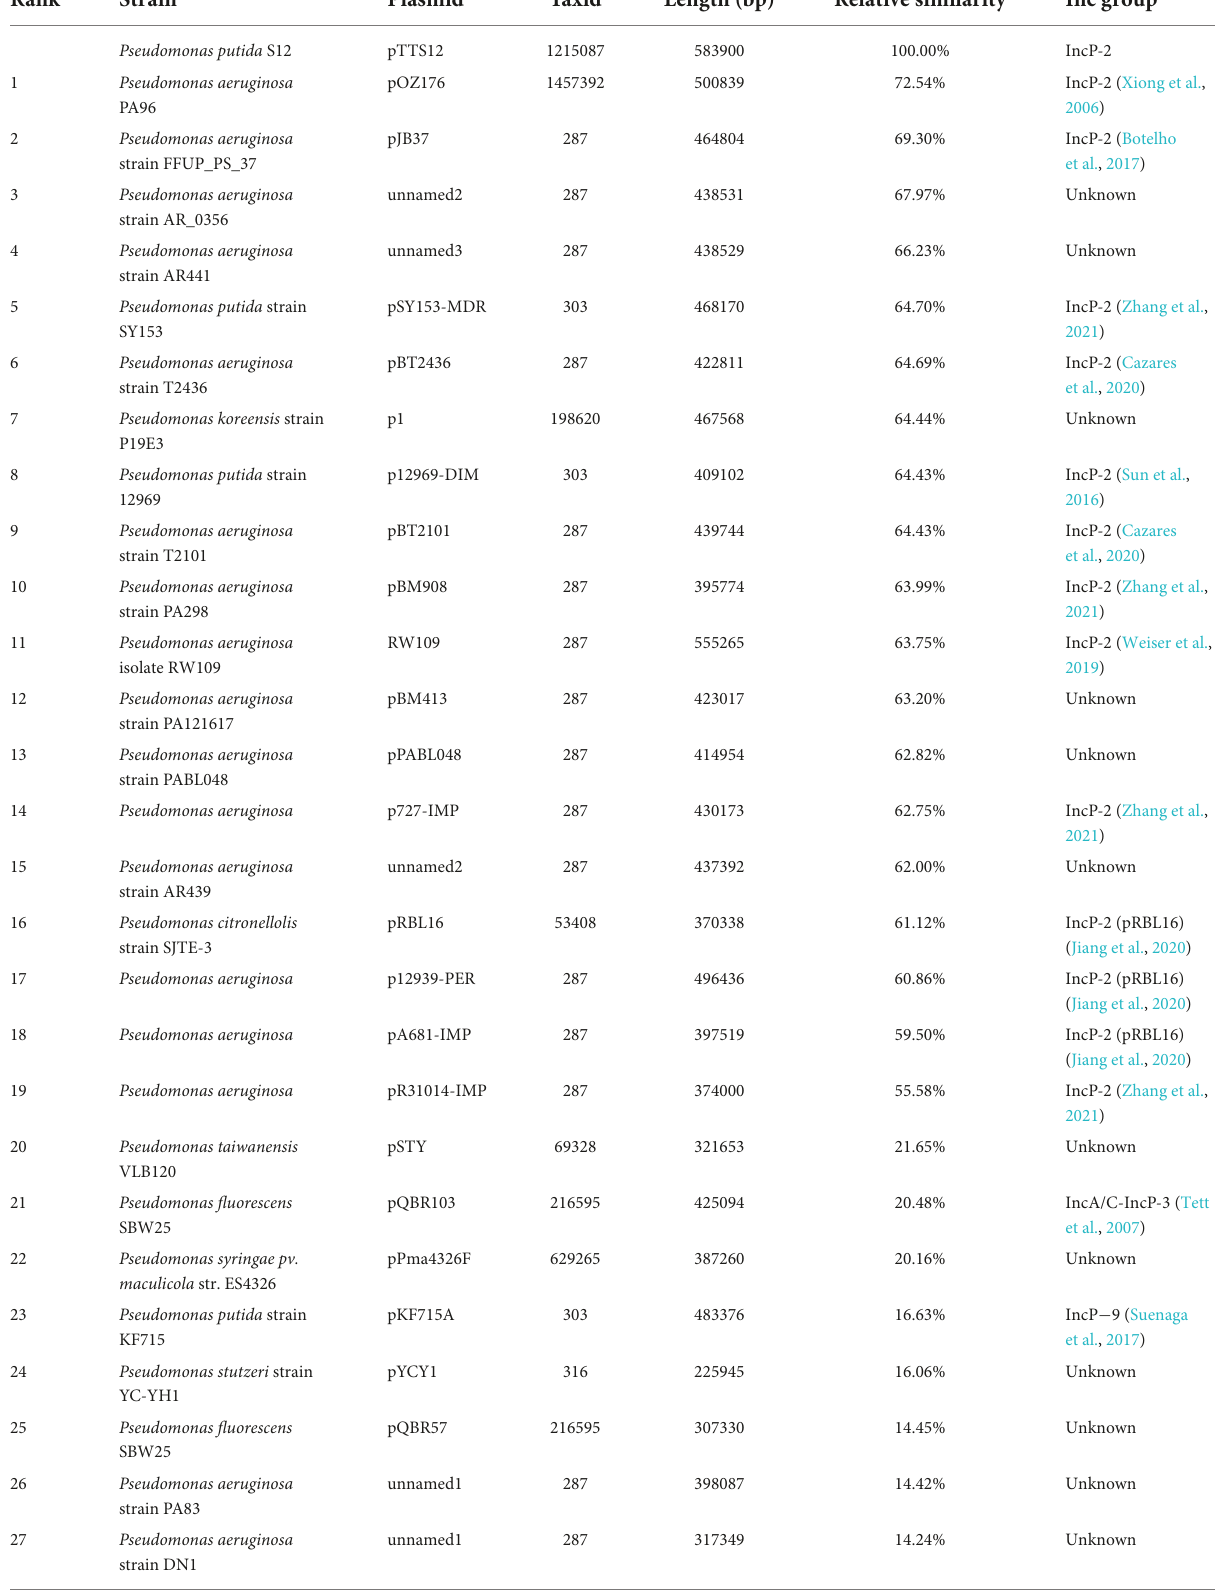
TABLE 3 List of 50 plasmids with the highest similarity scores to